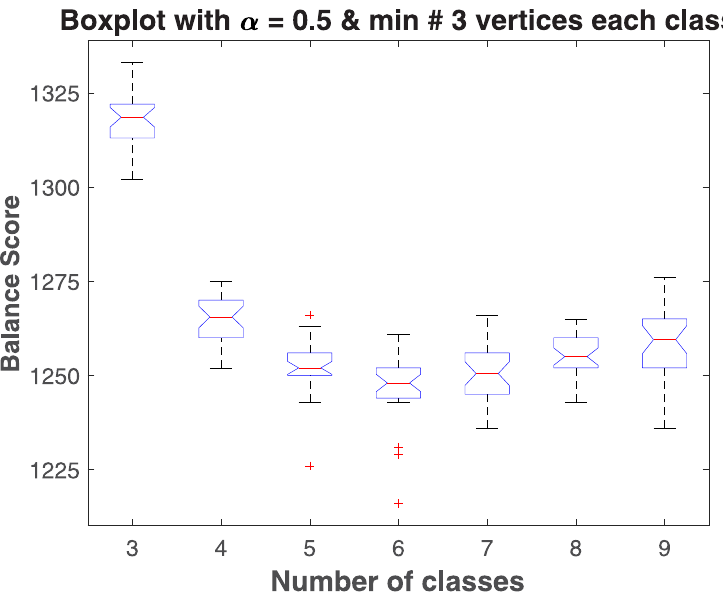
Fig 4. Boxplot of balance score versus number of classes as these are varied from three to nine. The concave shape indicates that the optimal number of classes, on the basis of balance score, is six.